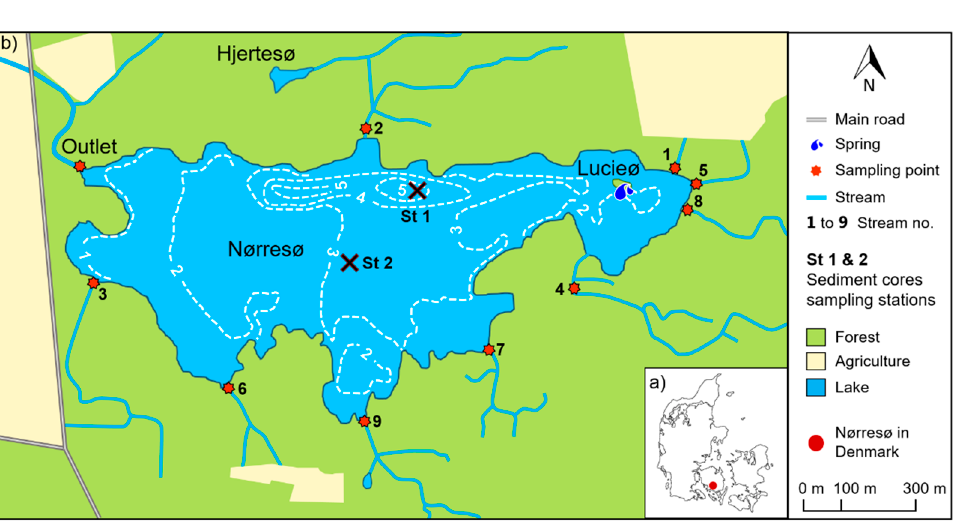
Figure 1. ( a ) Location of Nørresø in the southern part of Fyn, Denmark. ( b ) Locations of the outlet, the nine inlet streams and their respective numbering, and of station 1 and 2 from where sediment were cored in the present study. The small island, Lucieø, hosts a spring. A small lake, Hjertesø, north of Nørresø, is indicated. Dashed white lines indicate lake bathymetry in meters [47].